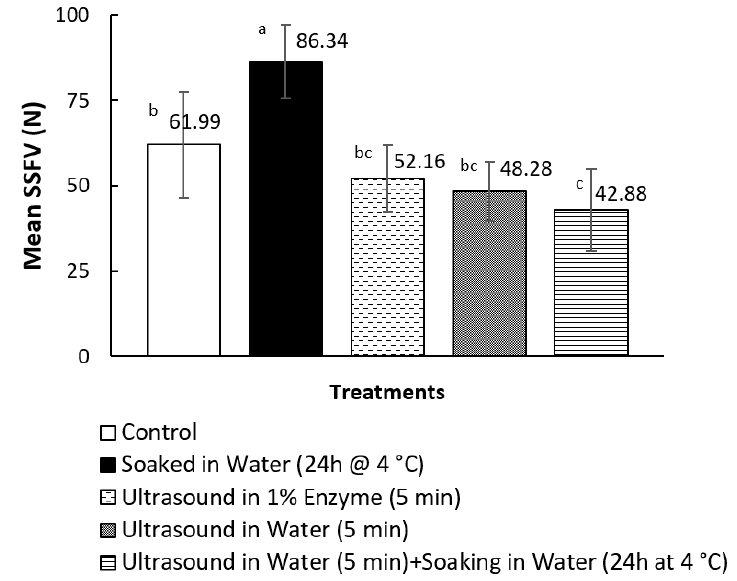
Figure 2. Effect of pre-treatments on the mean sliced shear force values (SSFV) of canned and cooked p ā ua. N = 3; means that do not share a letter are significantly different ( p < 0.05).